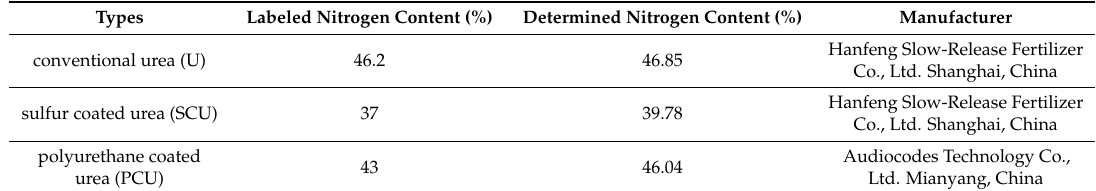
Table 1. Basic information of tested